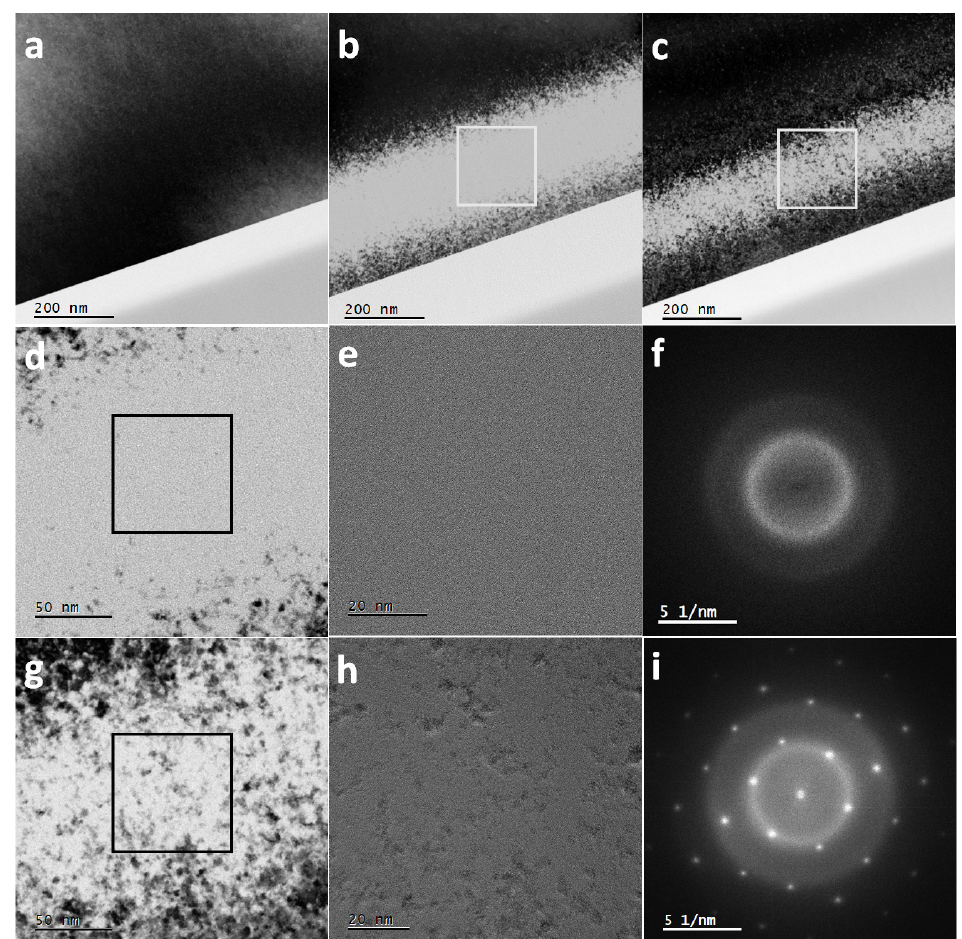
Figure 2. Cross-sectional BF TEM images of silicon irradiated with: ( a ) 23 MeV iodine, ( b ) 600 keV iodine and ( c ) both 600 keV and 23 MeV iodine. Magnified region ( d ) and HRTEM image ( e ) of the damaged zone (denoted by the square in ( b ) and ( d ), respectively), ( f ) corresponding FFT of image ( e ). Magnified region ( g ) and HRTEM image ( h ) of recovered zone (denoted by the square in ( c ) and ( g ) respectively), ( i ) the corresponding FFT of ( h ).